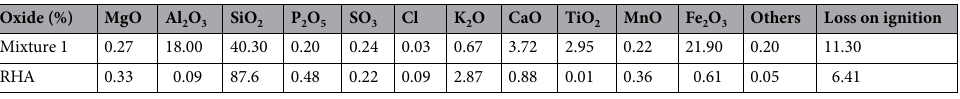
Table 7. Chemical composition of Mixture 1.